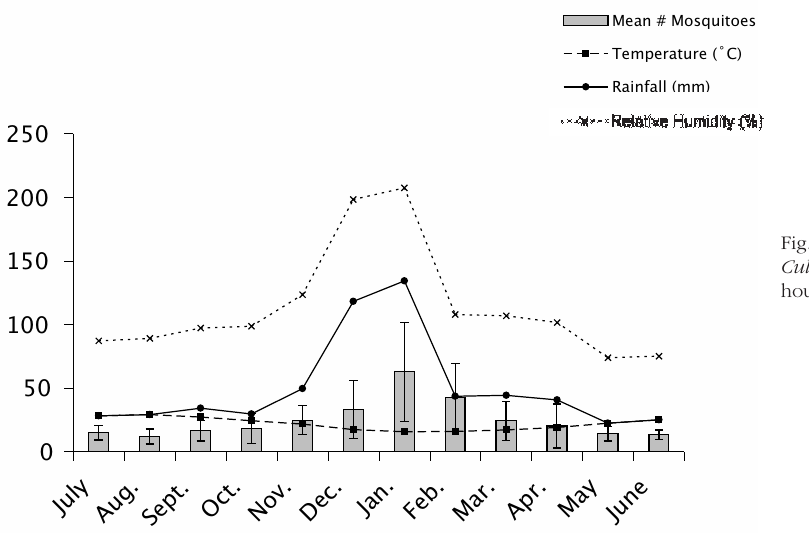
Fig. 2. – Changes in the population density of Culex pipiens females as observed in the monitored houses during